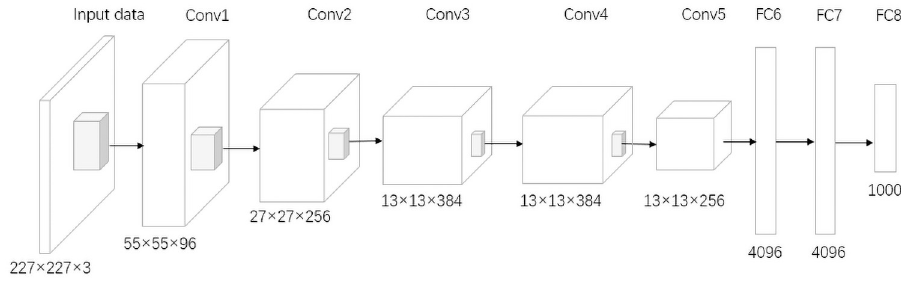
Fig 2. Alexnet model